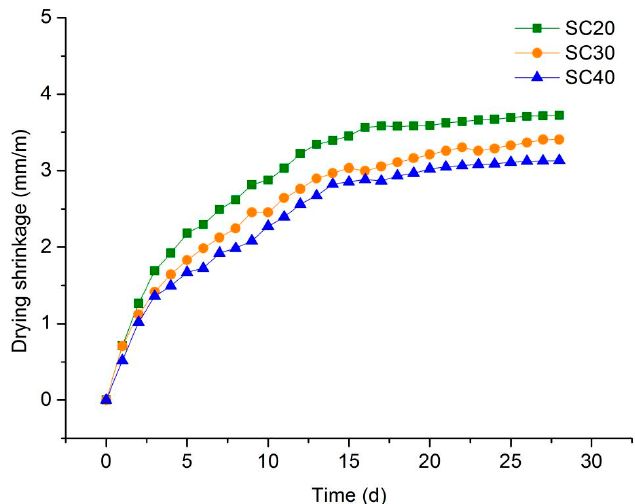
Figure 7. Drying shrinkage of series II mixtures.